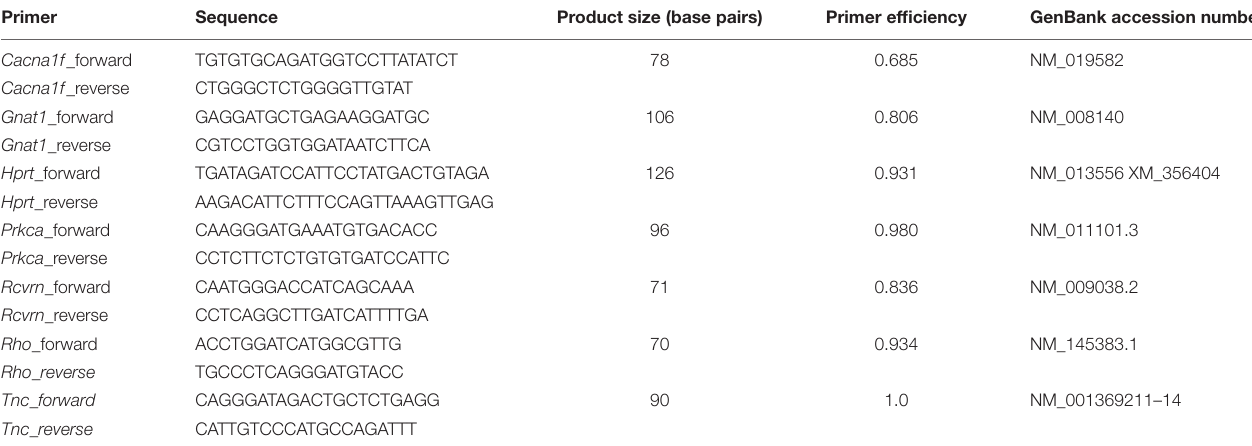
TABLE 3 | List of primer pairs used for RT-qPCR analyses. Primer Sequence Product size (base